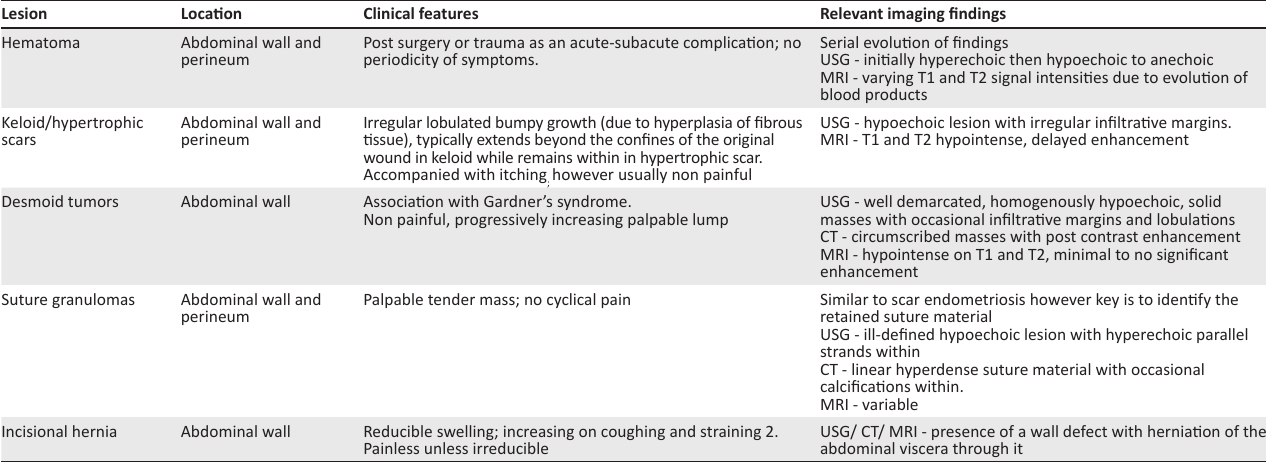
TABLE 1: Differential diagnoses of surgical scar endometriosis.